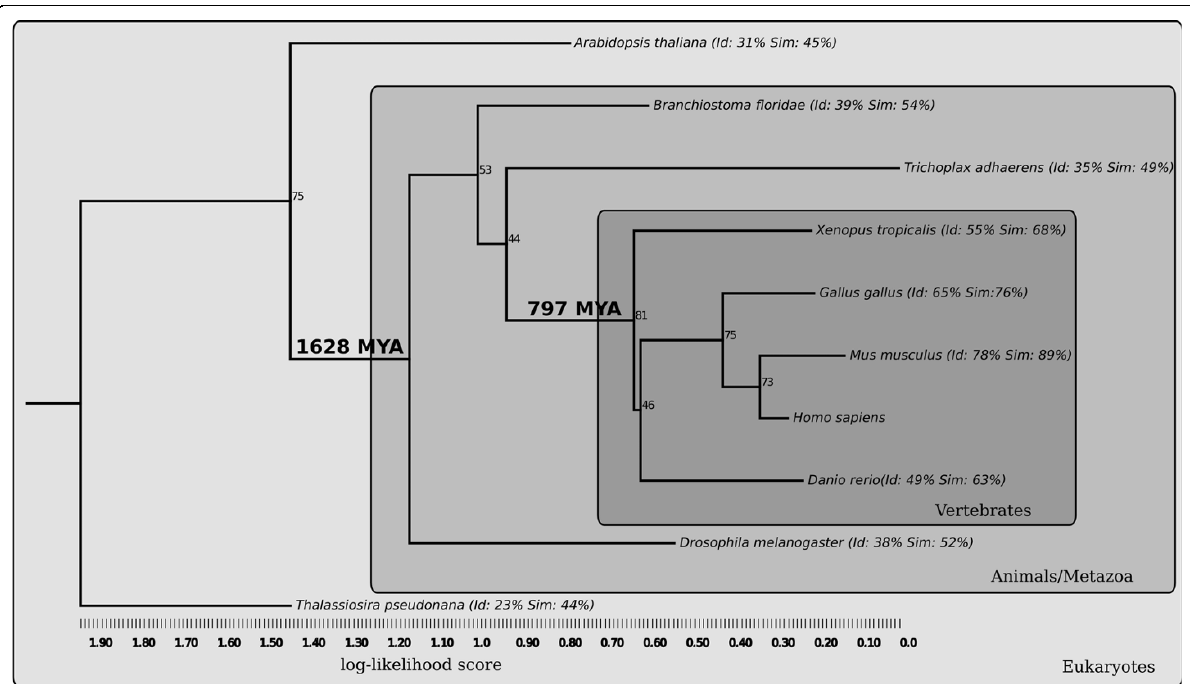
Figure 3 Phylogenetic tree of the TMEM18 family . The phylogenetic tree was calculated from a nucleotide multiple sequence alignment with a maximum-likelihood approach using the RAxML program. The tree was bootstrapped 1000 times and branch lengths correspond to log- likelihood scores (see scale). The sequence similarities and identities (percentage of alignment length) for each protein are towards the human TMEM18 protein and were calculated from global alignments produced with the EMBOSS implementation of the Needleman-Wunsch algorithm. The time points since the divergence of animals and plants/ T. pseudonana (1625 MYA) and since the radiation of vertebrates (797 MYA) were taken from the TimeTree